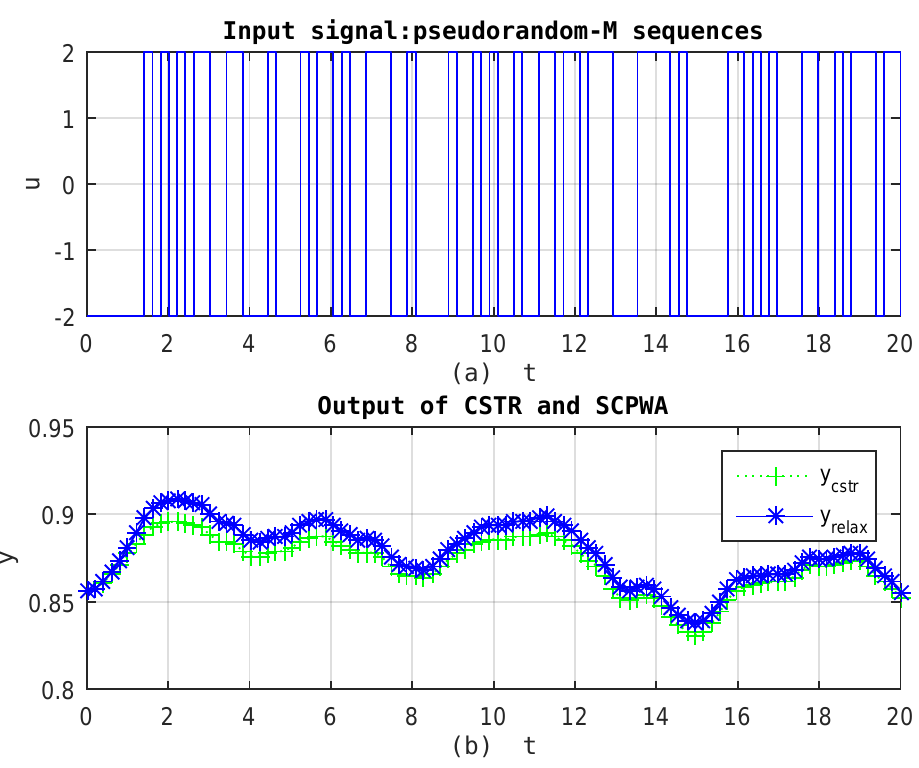
Figure 6. Trajectories of output of SCPWA and CSTR with the pseudorandom-M sequences as